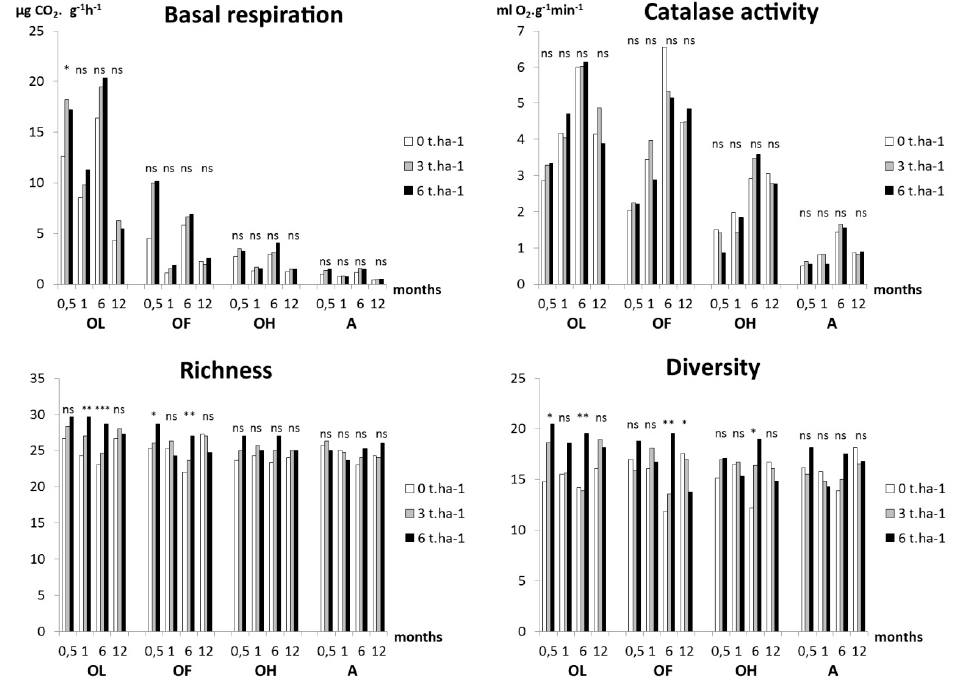
Figure 3. Comparisons of soil microbial community characteristics under different WA treatments. Significances of F -tests of one-way ANOVAs by horizons and sampling dates are shown (*** p < 0.001, ** p < 0.01, * p < 0.05, ns p ě